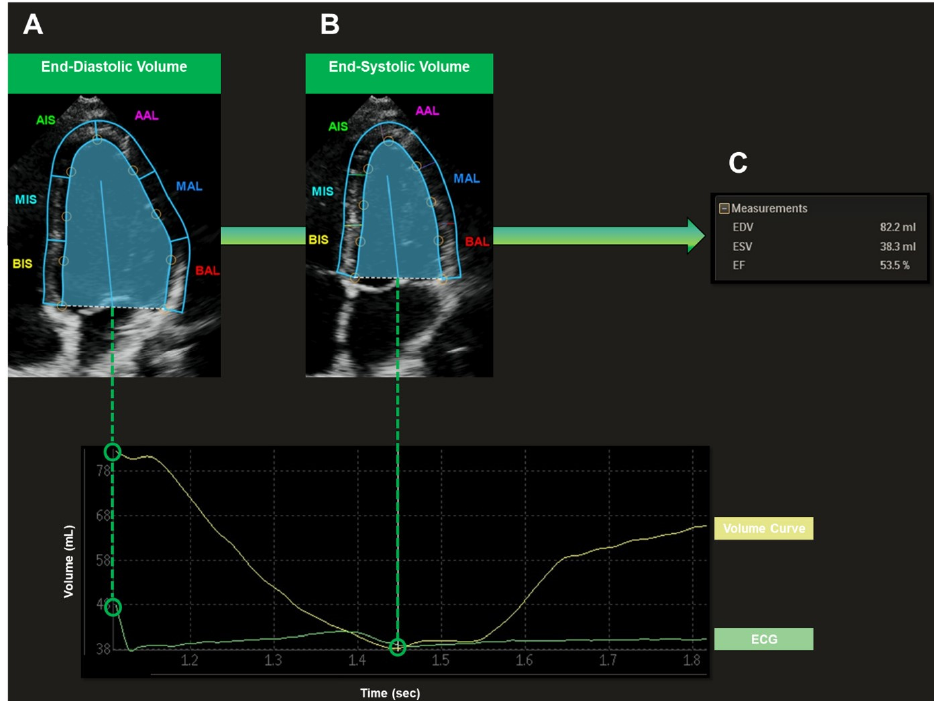
Figure 1. Semiautomatic Assessment of Left Ventricular Volumes Recorded in Apical Four-Chamber View. End-diastole ( A ) (R wave in ECG) and end-systole ( B ) (end of T wave in ECG) were set automatically by the software. The LV endocardium was marked precisely by the investigator in end-diastole ( A ) and end-systole ( B ). The following parameters were then acquired semiautomatically by the software ( C ): EDV, end-diastolic volume; ESV, end-systolic volume; SV, stroke volume; EF, ejection fraction.